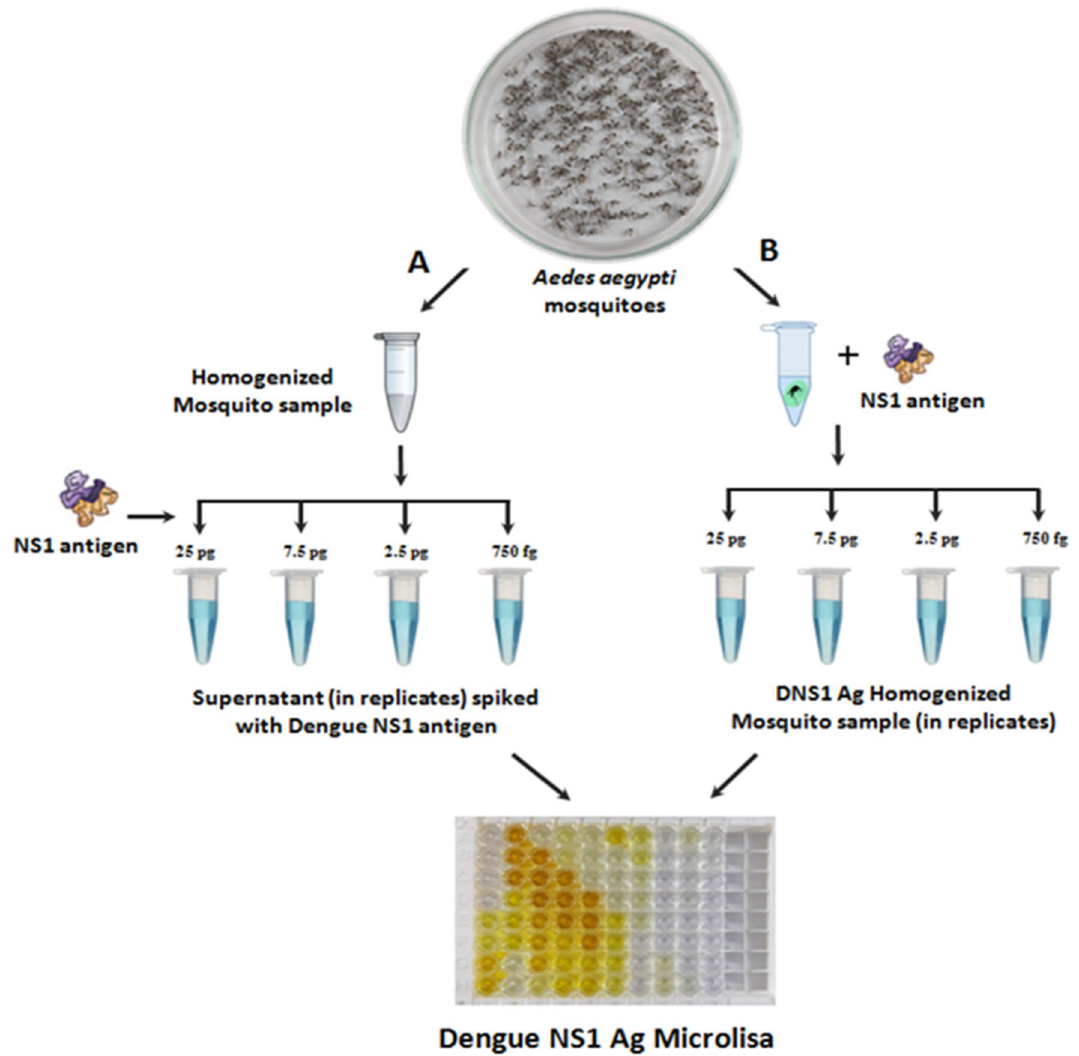
Figure 1. Design of spiking experiment. ( A ) The rDENV-2 NS1 antigen was added to the mosquito homogenate or ( B ) the mosquitoes were homogenized with rDENV-2 antigen and ELISA was 5 min and centrifuged at 5000 rpm (5 min.). Recombinant dengue NS1 antigen (25 pg to 750 fg) was spiked in the mosquito homogenate and ELISA was carried out. In the 2 nd procedure (B), the mosquitoes were spiked with the recombinant NS1 antigen at different concentrations (25 pg to 750 fg), homogenized and afterwards ELISA was performed following manufacturer’s protocol. Both the procedures were carried out in replicates. Detection of rDENV‑NS1 antigen in blood‑fed Ae. aegypti mosquitoes. This experiment was car- ried out to check whether the kit can detect the recombinant NS1 antigen in the blood-fed Ae. aegypti mosquito pools. Based on the results of the previous experiment, two concentrations of recombinant NS1 antigen (7.5 pg and 25 pg) were spiked with pools of 25 blood-fed and unfed homogenized mosquitoes. The homogenate was tested using the Dengue NS1 Ag Microlisa kit. Detection of NS1 antigen of dengue infected human serum in Ae. aegypti mosquito pools. For collection of serum sample from the DENV infected patient, approval from the Institutional Human Ethics Com- mittee (ECR 681/Inst/Py/2014/RR-17) of ICMR-Vector Control Research Centre, Puducherry was obtained. The patients enrolled for the study has signed an informed written consent. To simulate the condition of detection of secreted NS1 protein in the mosquitoes, serum of the DENV infected patient was spiked with Ae. aegypti mos- quito pools. Initially, the dengue positive patient’s sera samples (50 µl) tested by the kit to confirm the presence of NS1 antigen displayed OD > 6. Therefore, the sera samples were further diluted (1:50 and 1:100) in PBS and re- tested. Both the dilutions showed OD > 6 again. Based on this, homogenized Ae. aegypti mosquitoes (10 and 25 mosquitoes per pool) were spiked with both dilutions of serum (1:50 and 1:100 in PBS) and tested using the kit.